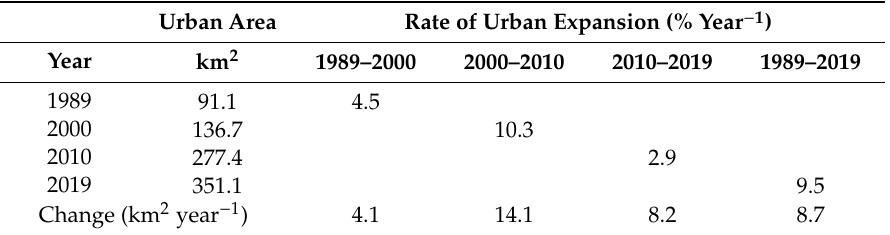
Table 7. Rate of urban expansion (RUE) in the study area between 1989 and 2019.